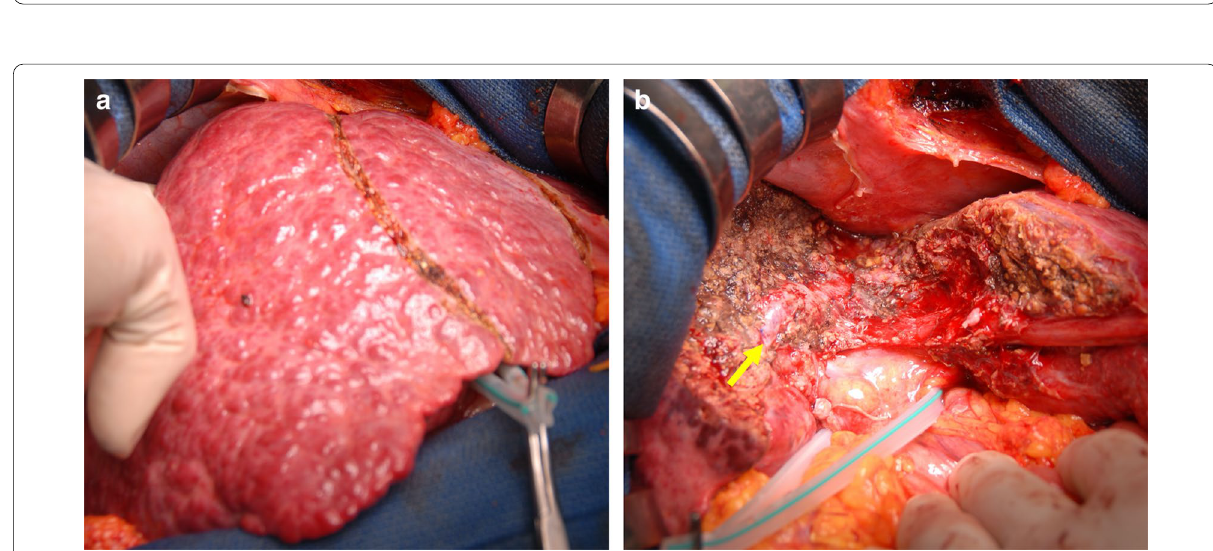
Fig. 2 Intraoperative photographs. The nodular appearance of the liver suggested the presence of cirrhosis ( a ). After liver resection, the macroscopic appearance of the liver was normal ( b ). The arrow indicates the middle hepatic